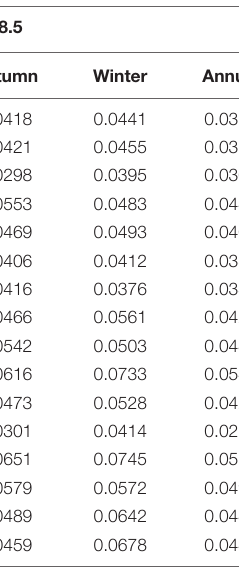
TABLE 2 | Sen’s slope values (in ◦ C/year) of annual and seasonal of Tmax (in ◦ C) at the 16 weather stations in Guangdong for the period of